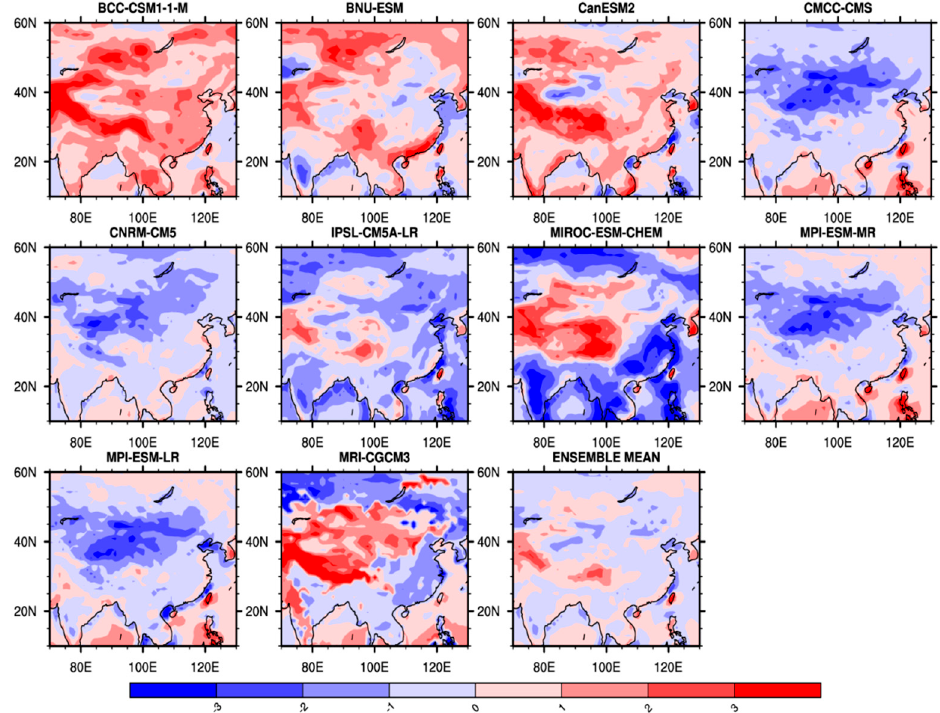
Figure 4. Spatial bias in 90 m hub-height mean wind speed (m / s) between the CMIP5 models, their ensemble mean and ERA-Interim from 1981–2005.